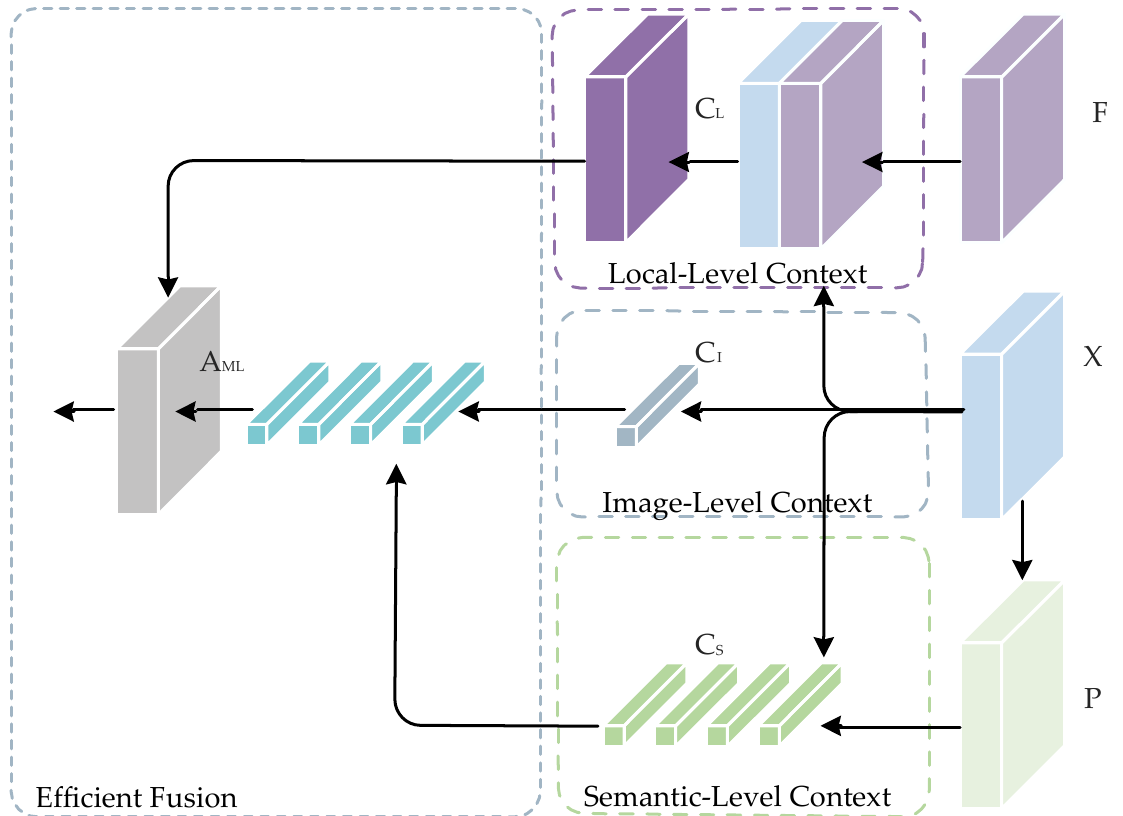
Figure 4. The efficient multi-level context transform (EMCT) module. The image-level contextual information C I is first embedded into semantic-level contextual information C S , then we further fuse them with local contextual information matrix C L by matrix multiplication to generate multi-level contextual attention matrix A ML